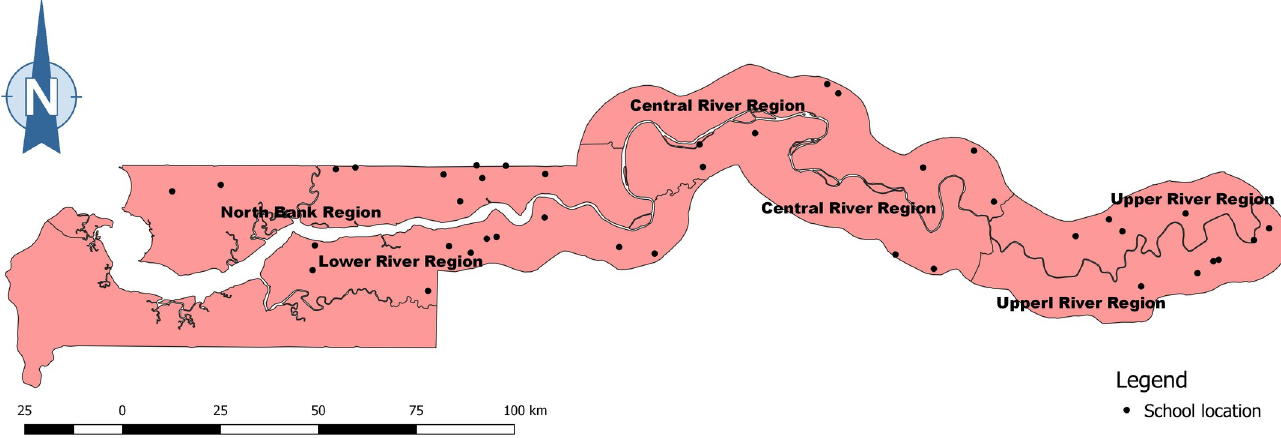
Fig 1. A map of The Gambia showing the locations of the 40 schools sampled across the 4 regions of the country. Link to map base layer used in creating this figure: https://data.humdata.org/dataset/gambia-administrative-boundaries.